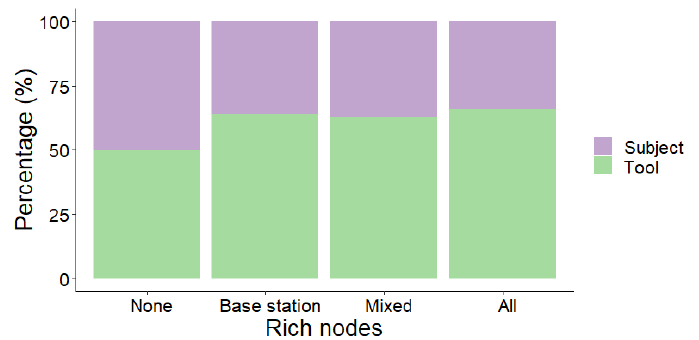
Figure 18. Deployment distribution between usage of rich nodes and deployment type.